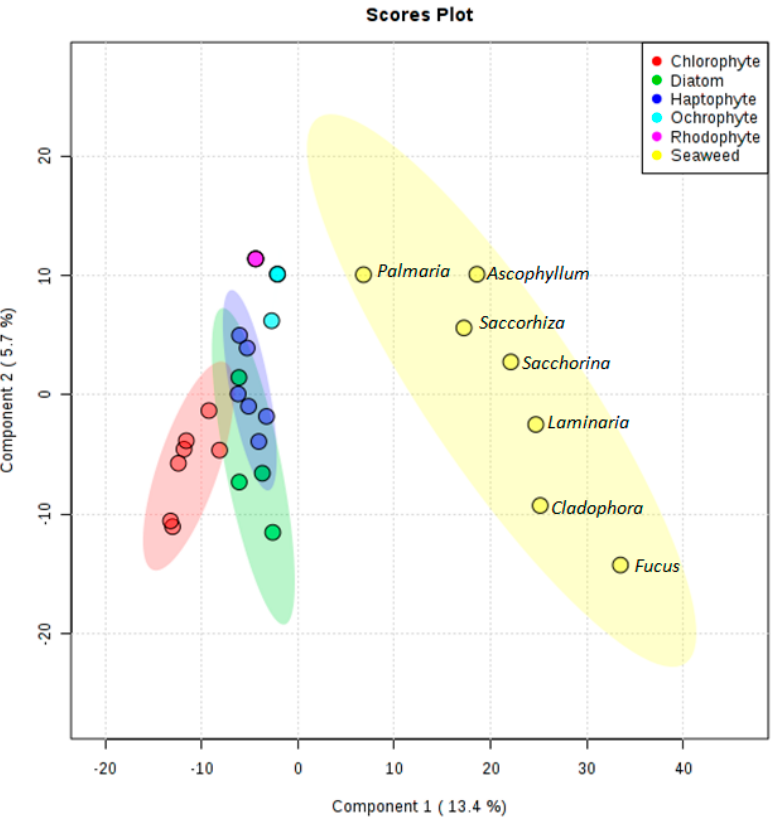
Figure 2. Partial least squares discriminant analysis (PLS-DA) scores plot for seaweed (yellow), Chlorophytes (red), diatoms (green), Haptophytes (dark blue), Ochrophytes (light blue), and Rhodophytes (pink) using component 1 (13.4%) and component 2 (5.7%) as axes.